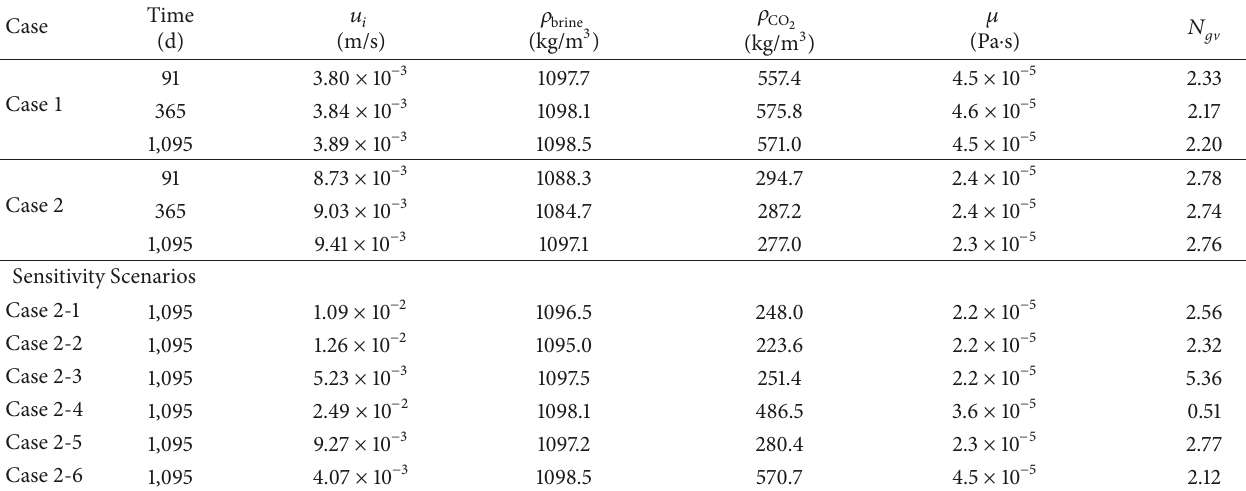
Table 4: Predicted gravity number for multiple cases as well as associated parameters used in